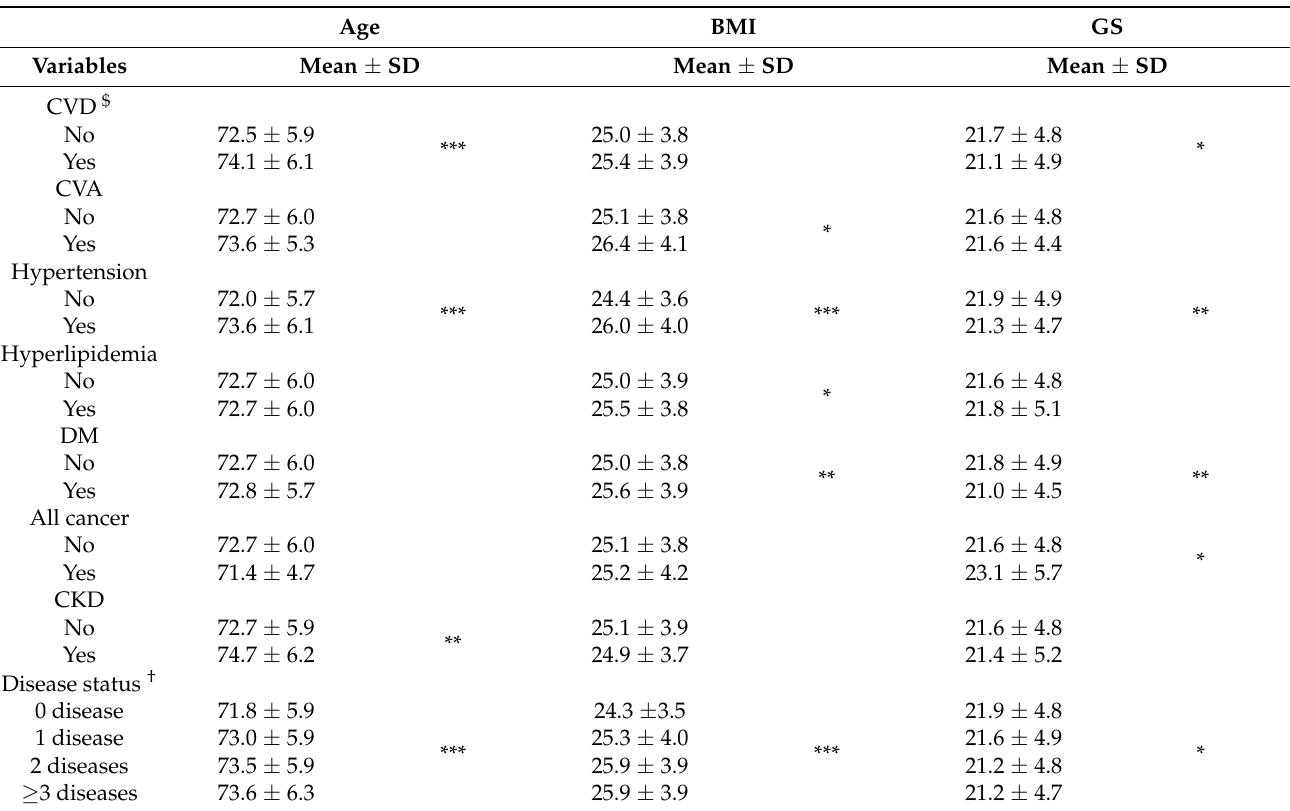
Table 3. Age, BMI, and grip strength distributions (mean ± SD) in different chronic disease statuses among female participants (n =